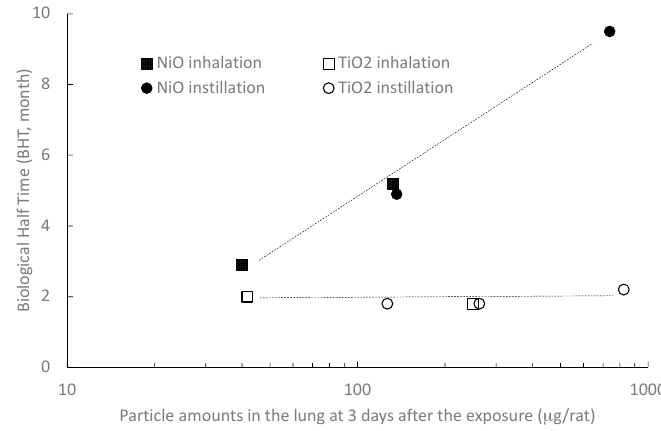
Figure 3. Relationship between lung burden and biological half time in inhalation and instillation studies.